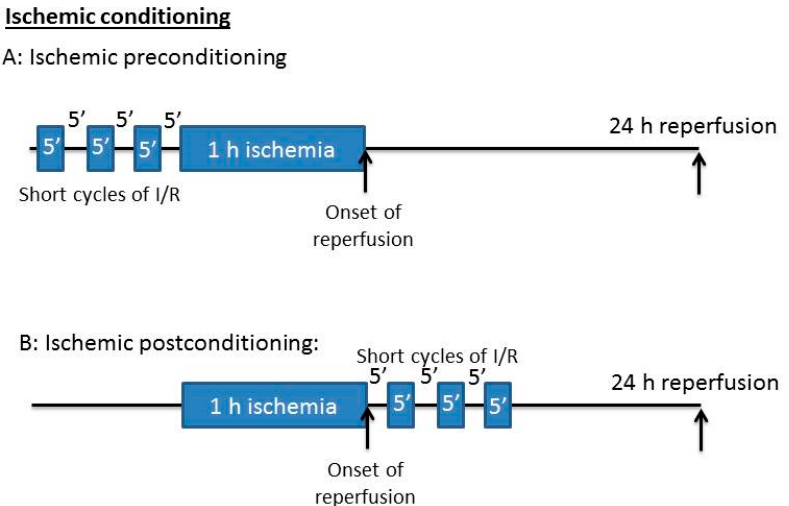
Figure 1. General scheme of ischemic preconditioning and ischemic postconditioning. The short cycles of ischemia reperfusion can be used either preconditioning induction ( A ) or postconditioning induction ( B ). As there are no standard procedures for ischemic conditioning, the number of cycles varies widely from investigator to investigator.